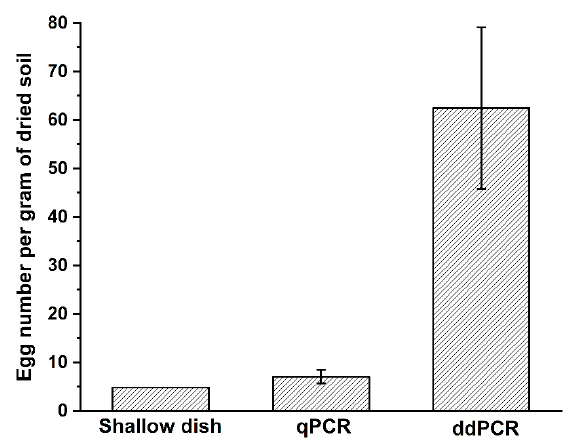
Figure 5. Egg density of M. enterolobii in field soil determined using shallow dish, qPCR, and ddPCR methods, respectively. The value obtained using the shallow dish method was calculated as a function of the number of juveniles hatched from soil, which was assumed as the number of eggs in soil.